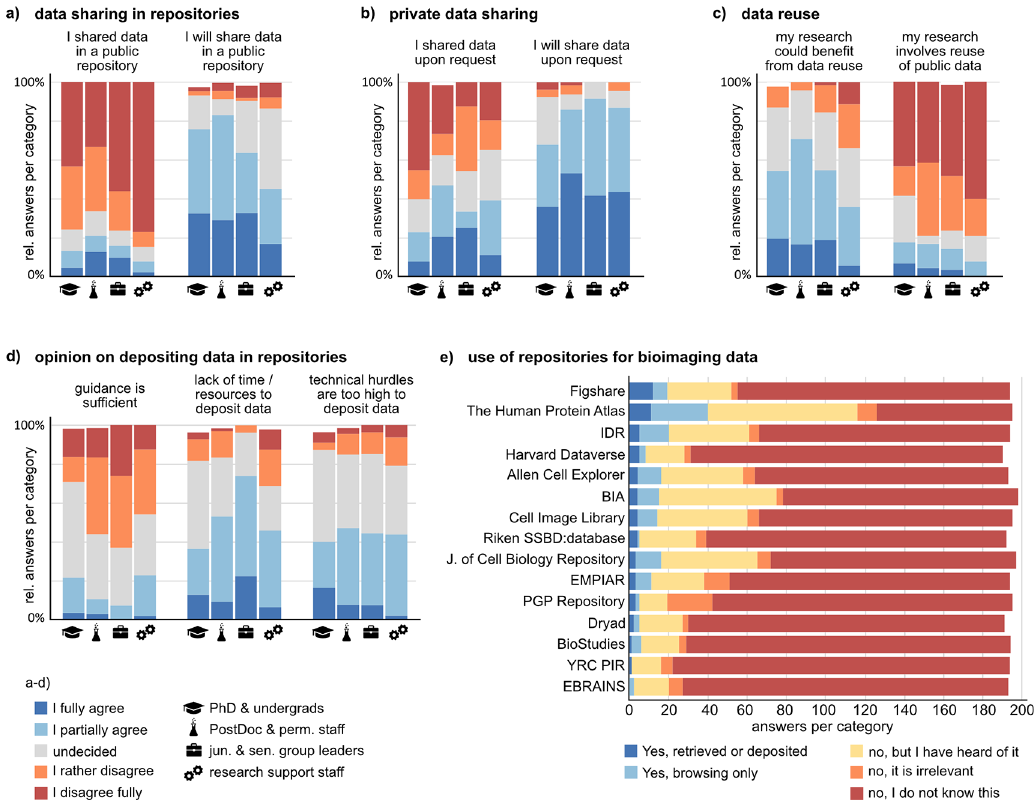
Figure 8. Experience with and opinion about bioimage data sharing. a, b, c) Shortened statements about private or public data sharing and data reuse. Shown are the relative answer distributions of the five agreement levels for each of the analyzed groups (undergraduate and PhD students, n = 55; Postdoctoral and permanent researchers, n = 66; junior and senior group leaders/professors, n = 27; Research support staff, n = 48). d) Opinions on three statementsaboutrepositories.e)Knowledgeanduseofpreselecteddatarepositoriesincludingbioimaging-specific, research-area-specific, andgeneric repositories. See Suppl.Figure 12 35 forthe fullsetof questions corresponding to thisfigure.Abbreviations:BIABioImageArchive;EMPIARElectronMicroscopyPublicImageArchive;IDRImageData Resource; PGP Plant Genomic and Phenomics; YRC PIR Yeast Research Center Public Image